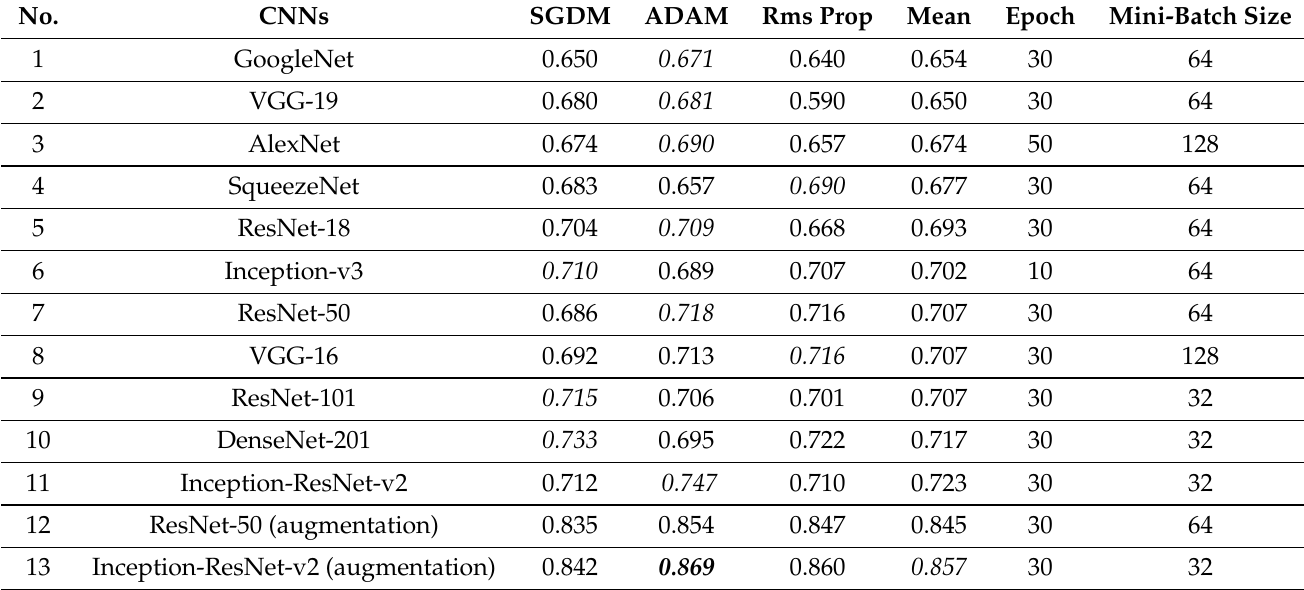
Table 6. Results of accuracy for eleven convolutional neural networks used to classify the wrist images in the MURA dataset. The best results for each row are highlighted in italics and the overall the best results are highlighted in bold .